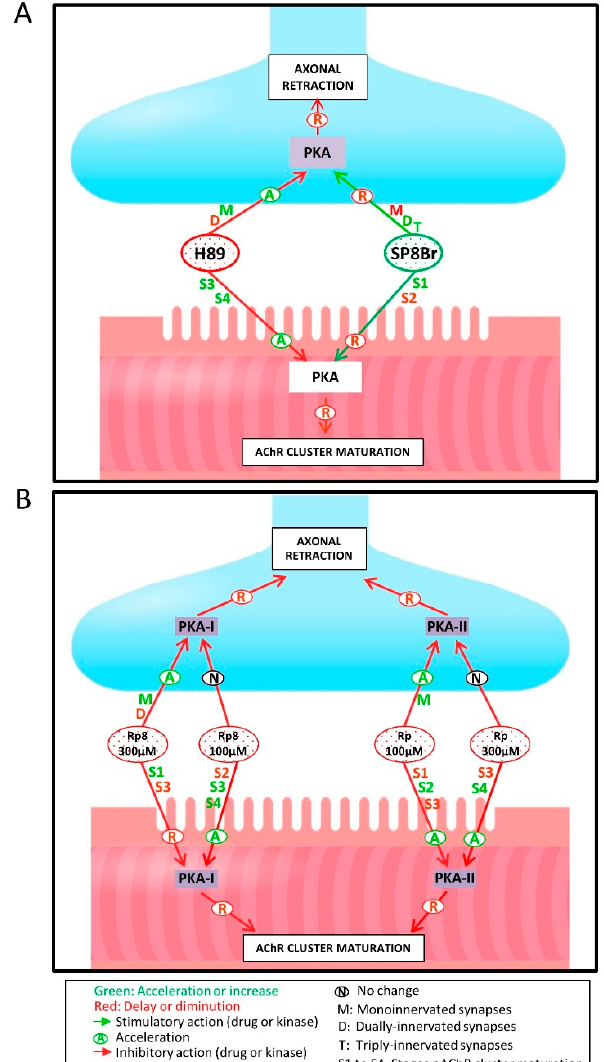
Figure 3. Diagrammatic representation of PKA involvement in pre- and postsynaptic NMJ maturation. ( A ) shows the effect on axonal retraction and nAChR cluster maturation of the unselective PKA inhibitor H-89 and stimulator Sp8Br. In ( B ), the selective antagonists of the regulatory PKA subunits RI (Rp8, 100–300 μ M) and RII (Rp, 100–300 μ M) discriminate the involvement of the PKA-I and PKA-II isozymes at the synaptic sites. Overall pre- and postsynaptic PKA activity coordinately prevents NMJ maturation by stabilizing the developmental situation.